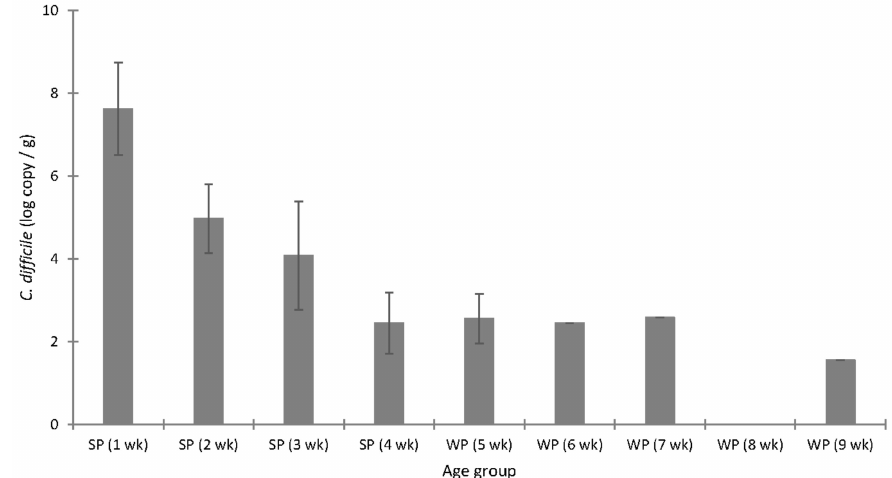
Figure 3. Concentration (mean ± SD, log 10 copy / g) of C. di ffi cile in faecal samples from the o ff spring ( n = 8–10) sampled weekly from one until nine weeks of age and analysed using qPCR, without previous sample enrichment. SP: suckling piglets; WP: weaned piglets.